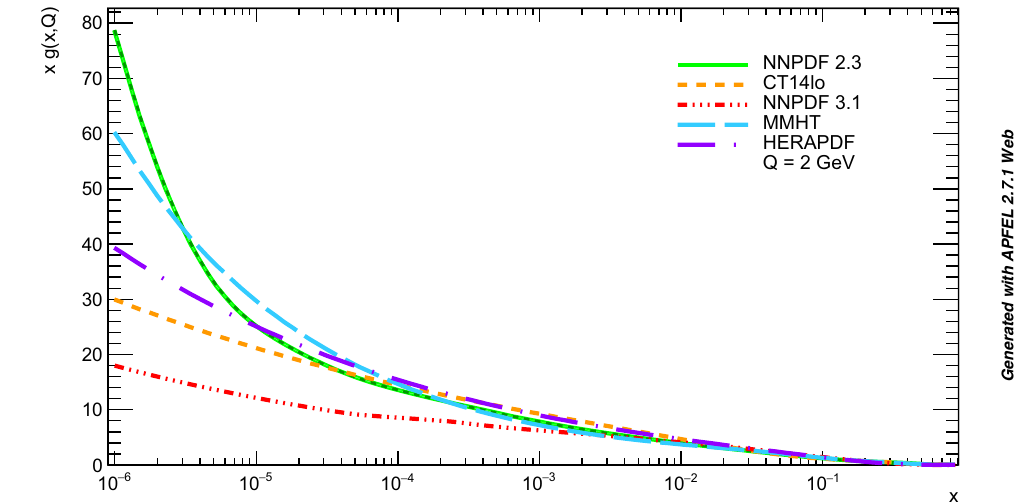
( a ) Comparison of LO PDF sets, central predictions only. The central member of the NNPDF 2.3 set